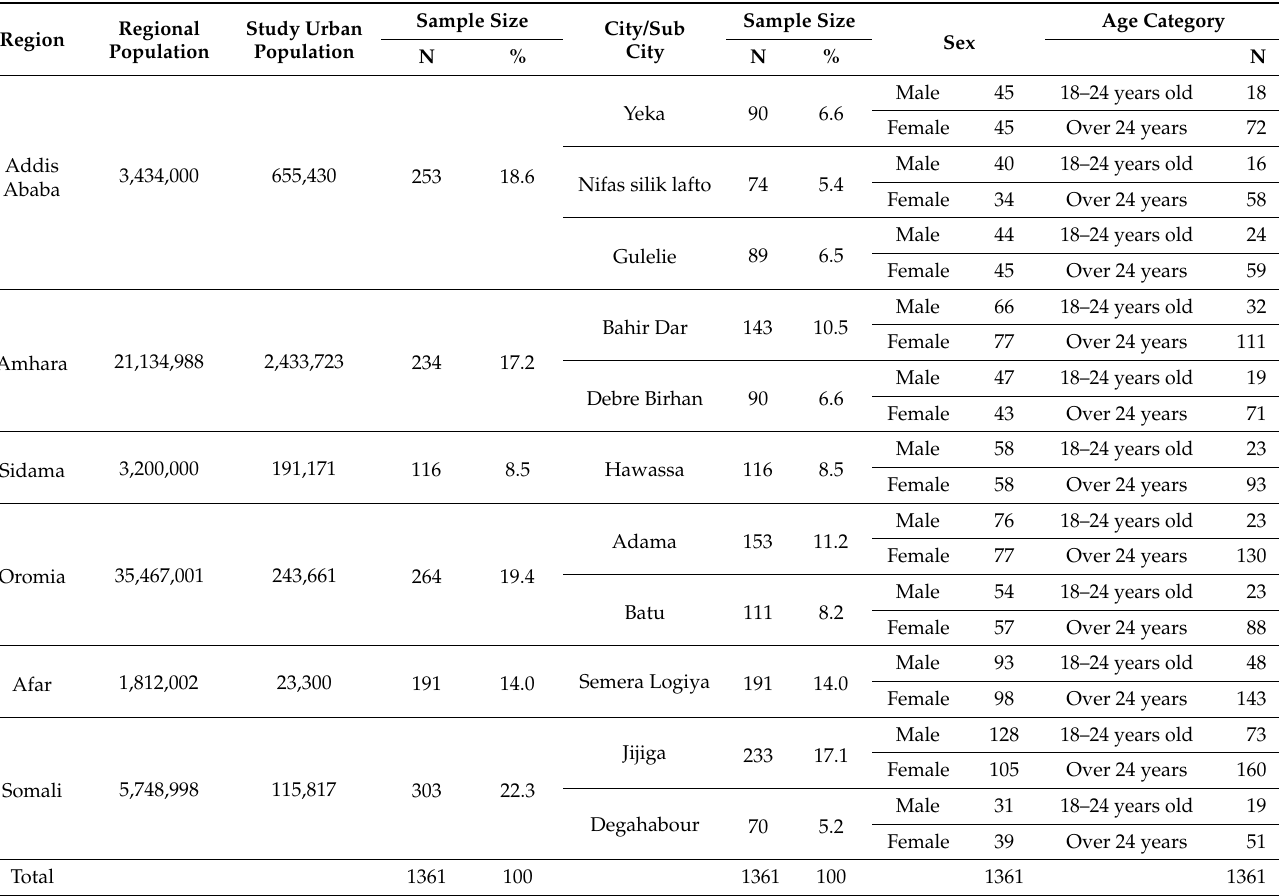
Table 1. Number of cities in each region, number of districts, and sample size distribution, shown according to region sub-city, district, sex, and